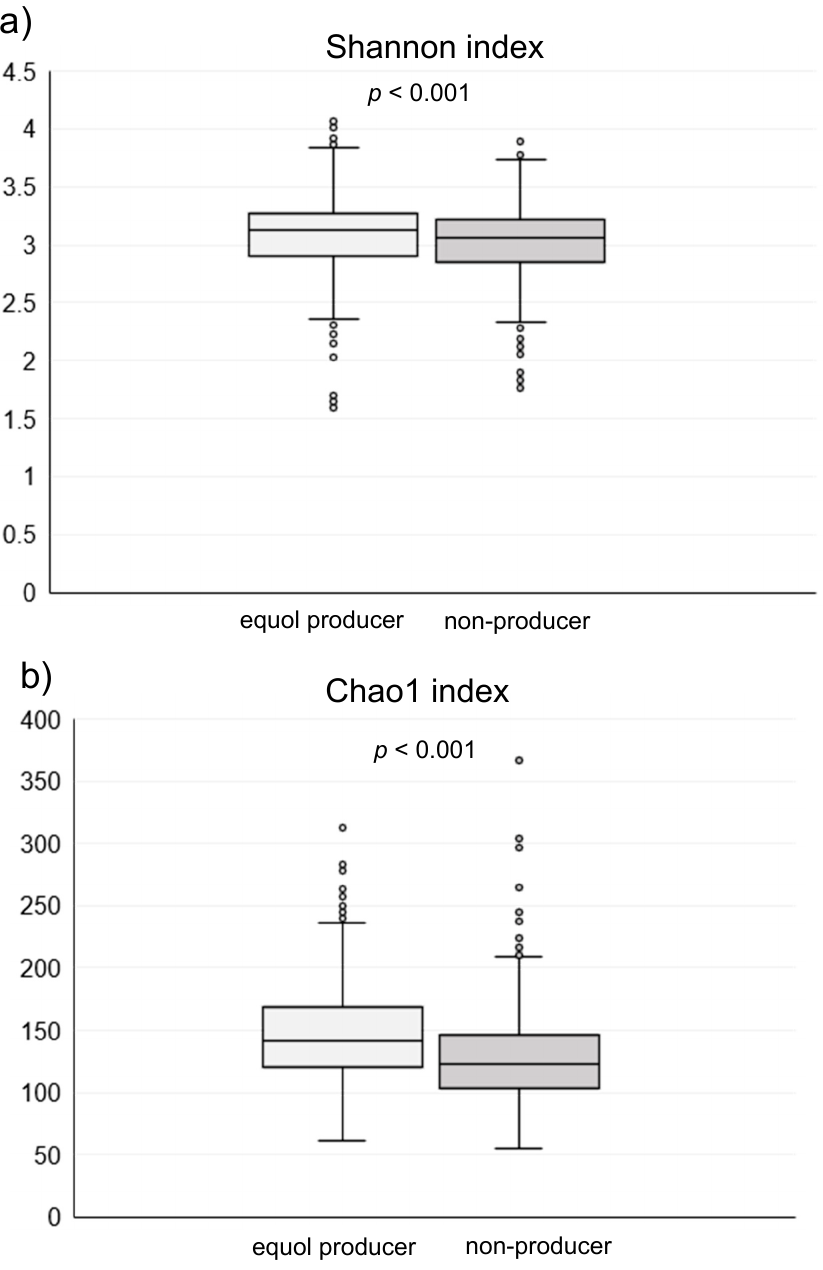
Figure 2. ( a ) The Shannon index and ( b ) Chao1 index of the gut microbiota in the equol producers and non ‐ producers.